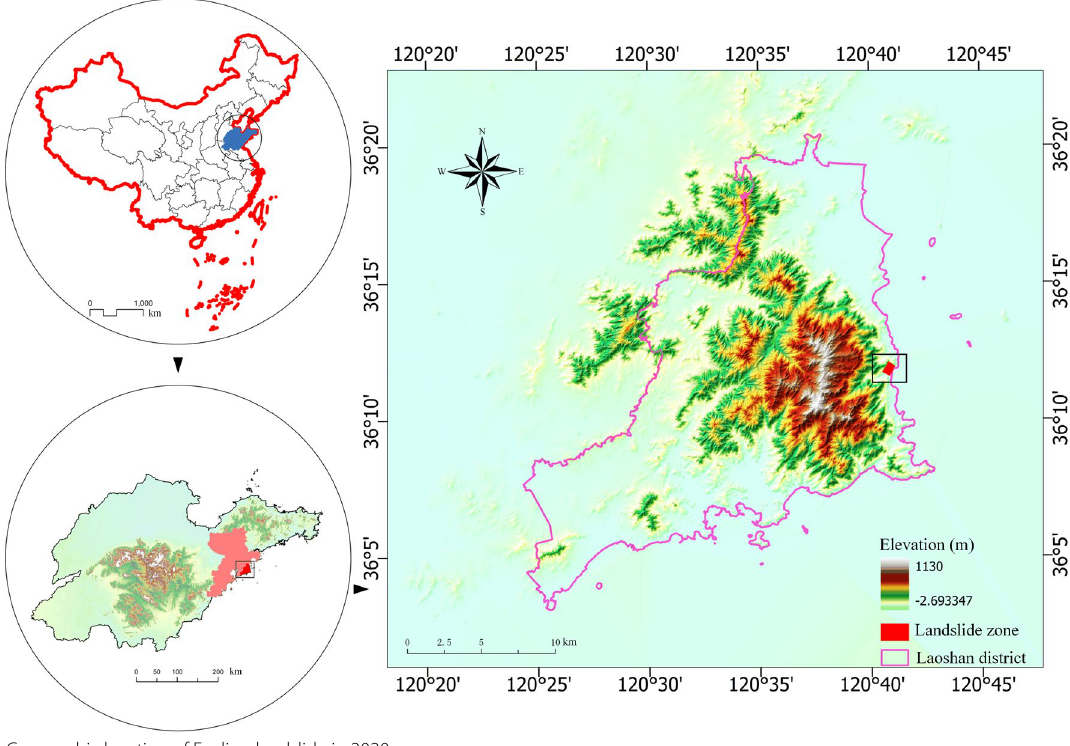
Fig. 2 Geographic location of Fanling landslide in 2020